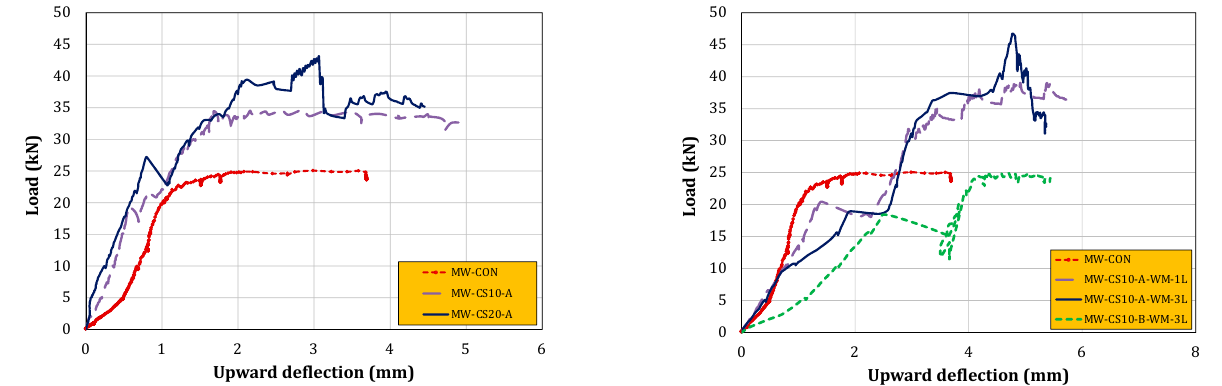
Figure 8. Load versus end deflection responses of the CCIB masonry walls.